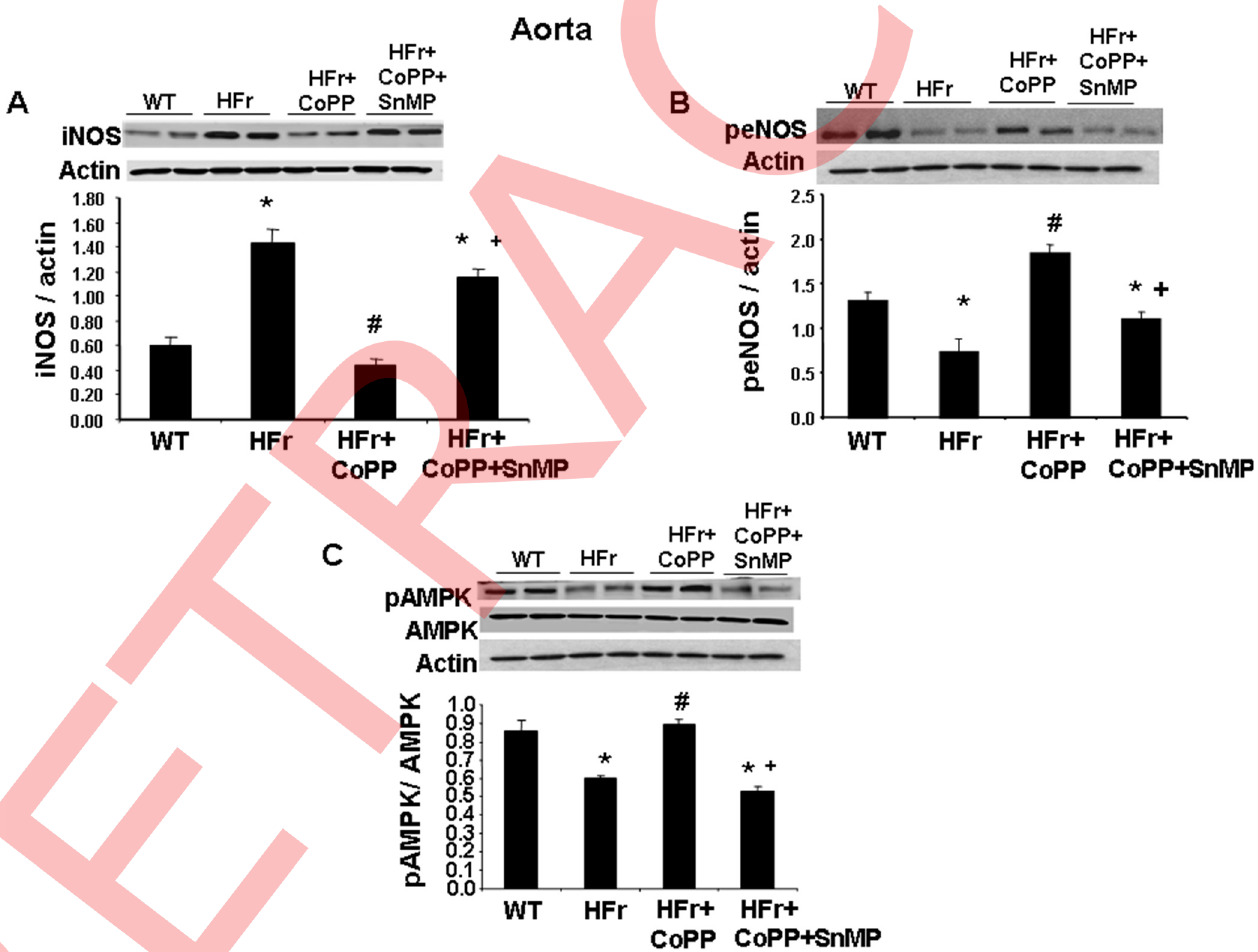
Fig 8. Effect of induction of HO-1 (CoPP) and inhibition of HO (SnMP) in mice fed a high fructose diet for 8 weeks on western blot and densitometry analysis of aortic tissue. (A) iNOS protein expression. (B) peNOS protein expression and (C) pAMPK protein expression. Data are shown as mean band density normalized to β -actin. Results are mean ± SE, n = 4/group. � p < 0.05 vs CTR; # p < 0.05 vs HFr, + p < 0.05 vs HFr+CoPP. Fig 8A-C Actin panels are excluded from this article’s CC-BY license. See the accompanying retraction notice for more information.